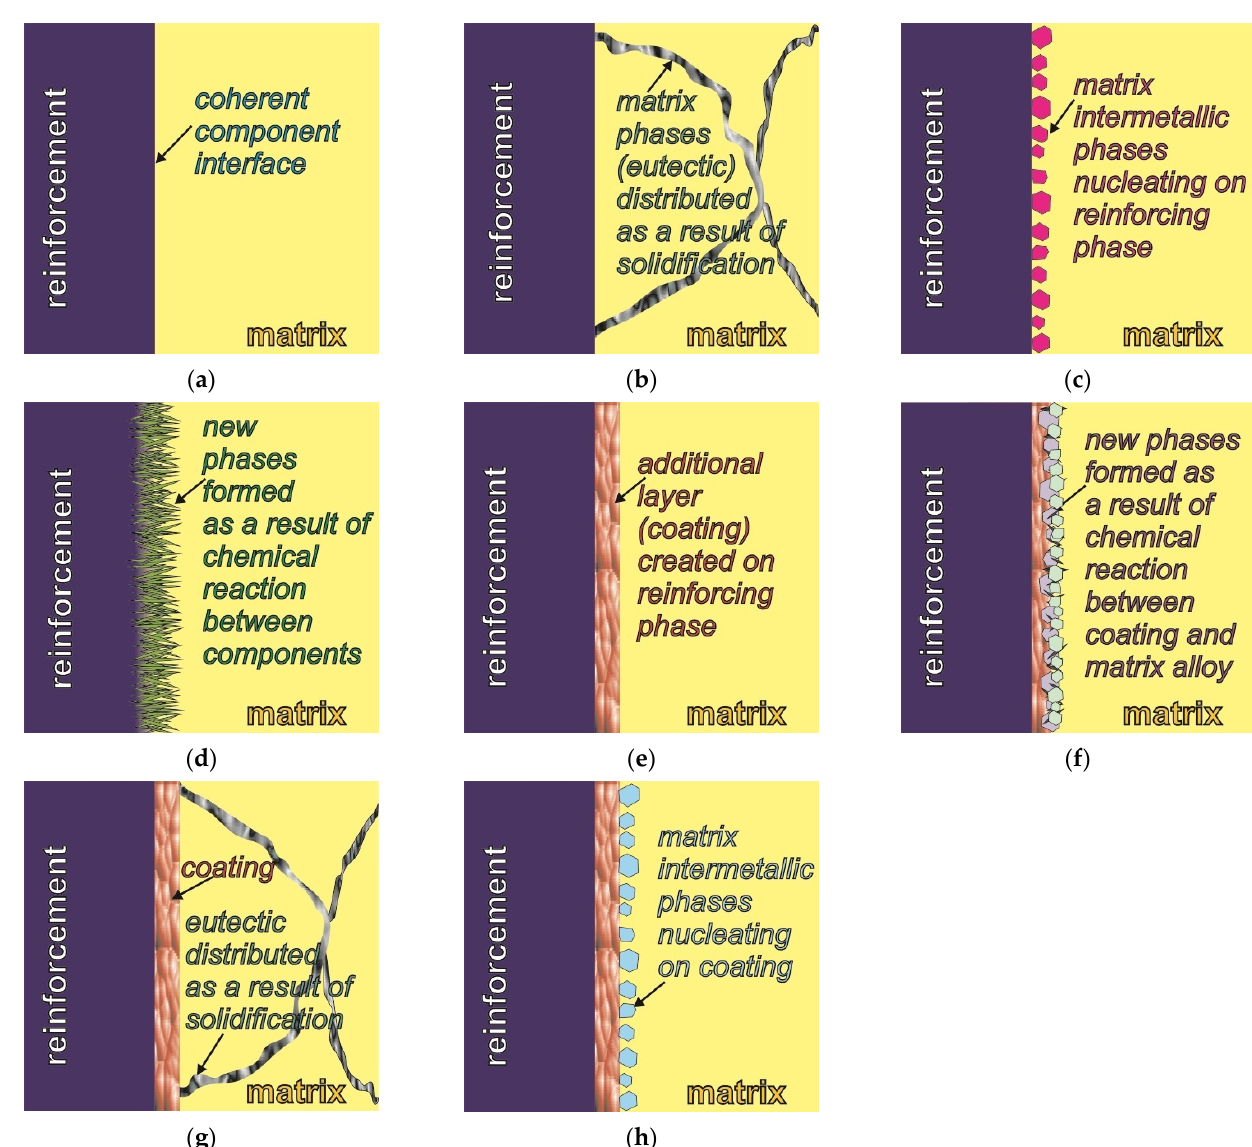
Figure 10. Scheme of types of interfaces between components in metal matrix composites: ( a ) coherent interface between components; ( b ) matrix phases (eutectics) distributed at component interface during solidification; ( c ) matrix phases (intermetallic) nucleated at reinforcement; ( d ) new phases at component interface forming due to reaction between components; ( e ) stable coating initially created on reinforcement; ( f ) new phases at component interface formed due to reaction between matrix alloy and coating layer; ( g ) matrix phases (eutectics) distributed during solidification; ( h ) matrix phases nucleated on coating.